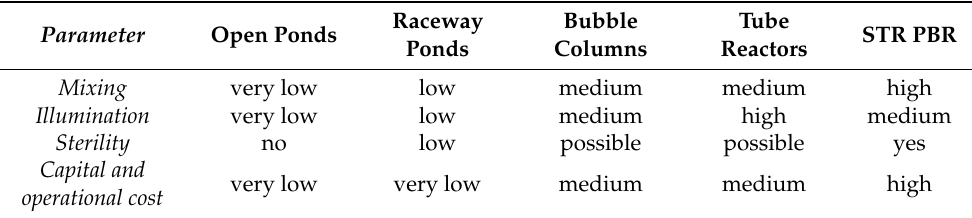
Table 1. Summary of microalgae cultivation strategies with regard to the main characteristics (STR PBR: stirred tank reactor photobioreactor).